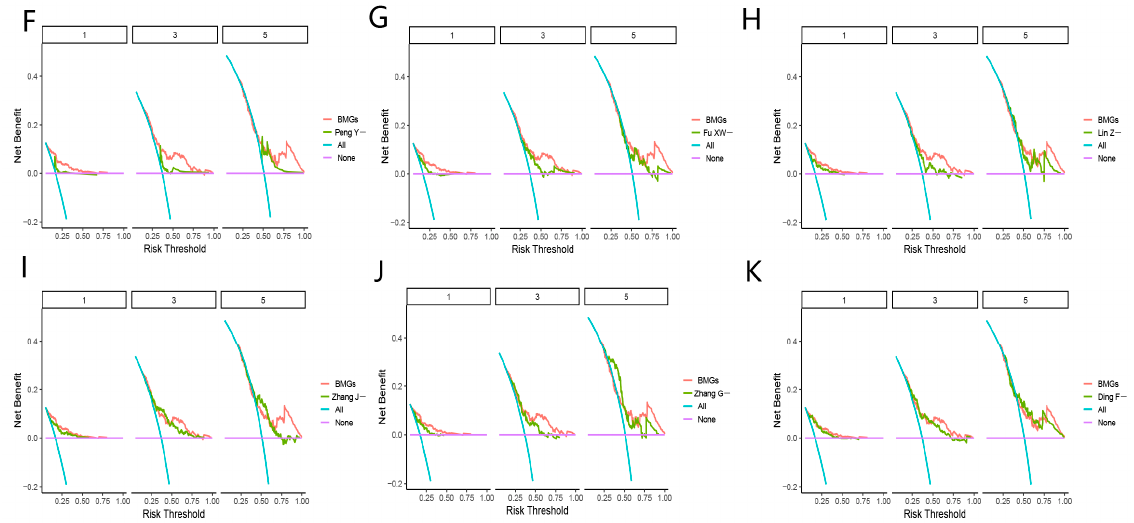
Figure 9. ( A ) BMGs and nine gene signatures in PubMed databases for prediction of the prognoses of HCC. ( B ) C-index analyses about BMGs and seven gene signatures in PubMed databases for prediction of the prognoses of HCC. ( C ) Decision curve analyses of BMGs and the Li Y-study. ( D ) Decision curve analyses of BMGs and the Yuan C-study. ( E ) Decision curve analyses of BMGs and the Wang Z-study. ( F ) Decision curve analyses of BMGs and the Peng Y-study. ( G ) Decision curve analyses of BMGs and the Fu XW-study. ( H ) Decision curve analyses of BMGs and the Lin Z-study. ( I ) Decision curve analyses of BMGs and the Zhang J-study. ( J ) Decision curve analyses of BMGs and the Zhang G-study. ( K ) Decision curve analyses of BMGs and the Ding F-study.